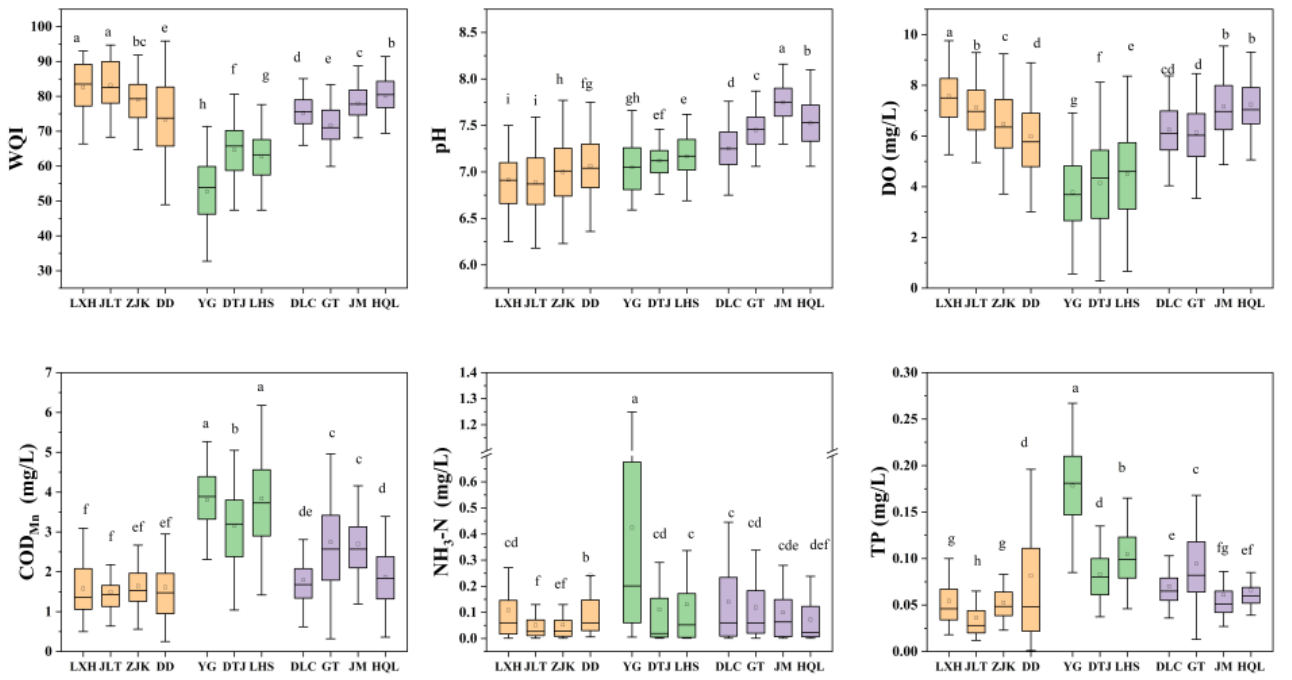
Figure 4. Spatial patterns of WQI and water quality parameters at different stations for monitoring water quality in the Guangzhou reach of the Pearl River from 2018 to 2021. Note: bars with different lowercase letters indicate statistically significant differences among stations (significance level = 0.05).